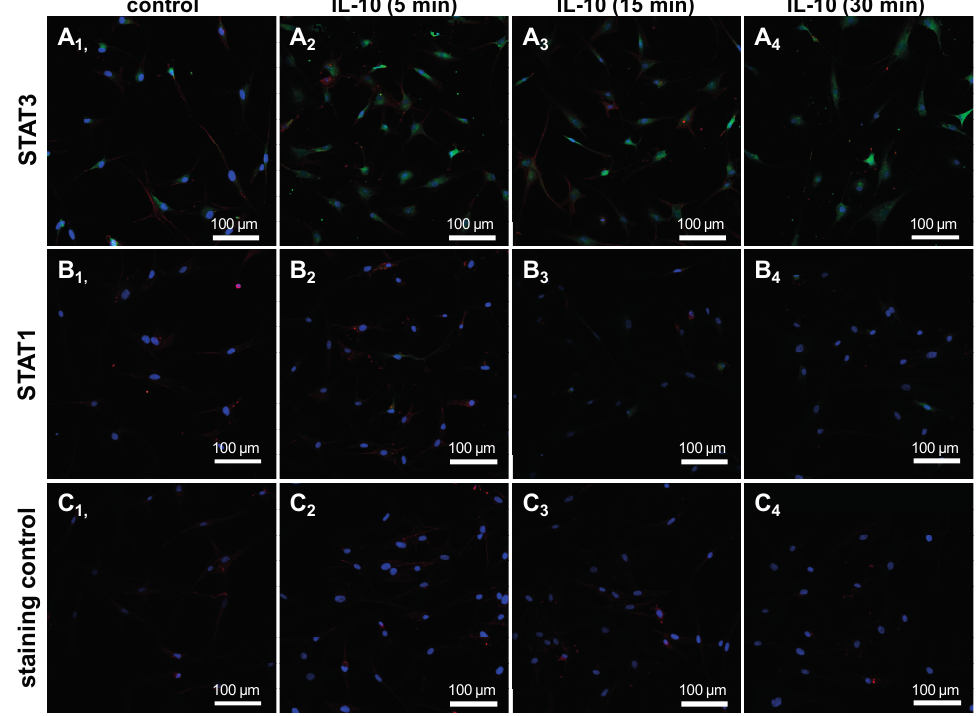
Figure 5. STAT3 and STAT1 expression in undifferentiated human MSCs. Undifferentiated MSCs were seeded (third passage) for 24 h on cover slips, serum starved and treated with 10 ng/mL recombinant IL-10 or remained untreated (control). Subsequently, the cover slips with MSCs were immunolabelled either with STAT3 ( A antibodies and Alexa-Fluor ® 488 coupled secondary antibodies (green). As a staining control the primary antibody was omitted ( C (blue). The cytoskeleton of the MSCs (also in the staining controls) is depicted using phalloidin-555 staining. A representative experiment of 2 tests with cells of 2 different donors is shown by confocal laser scanning microscopy. Scale bar = 100